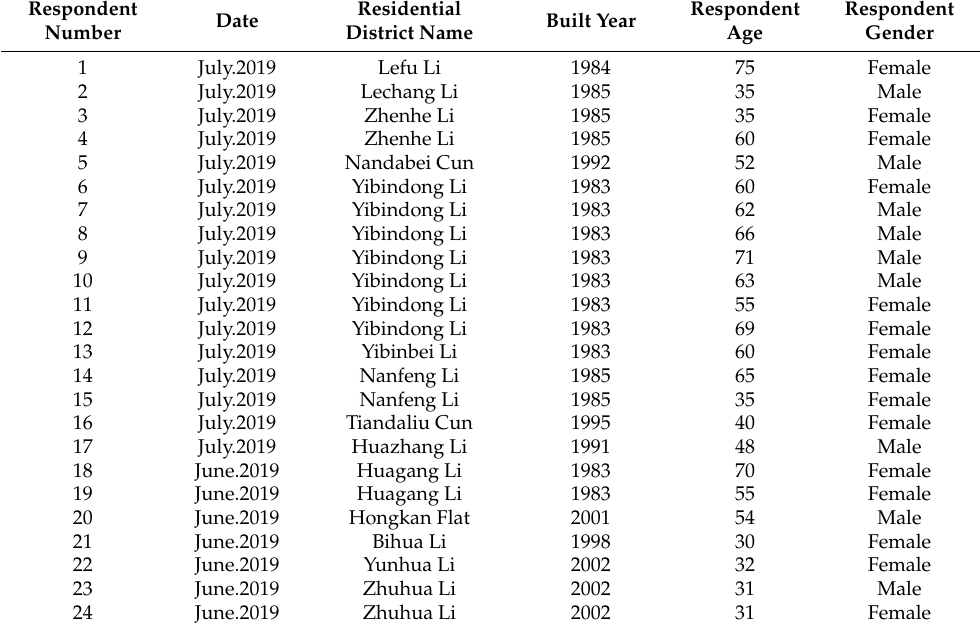
Table A1. Respondent information of in-depth interview.